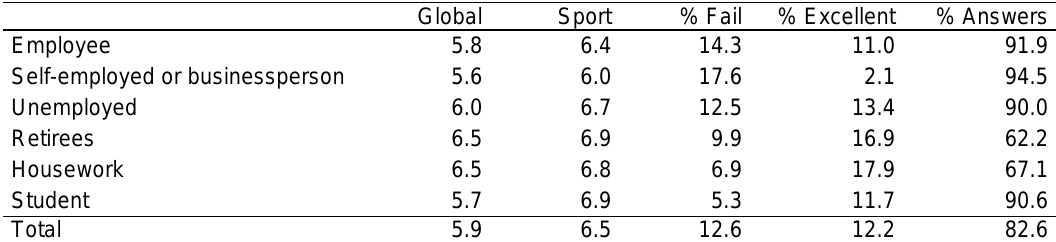
Table 4. Average assessment of municipal management by employment status (2017). Global Sport % Fail % Excellent %